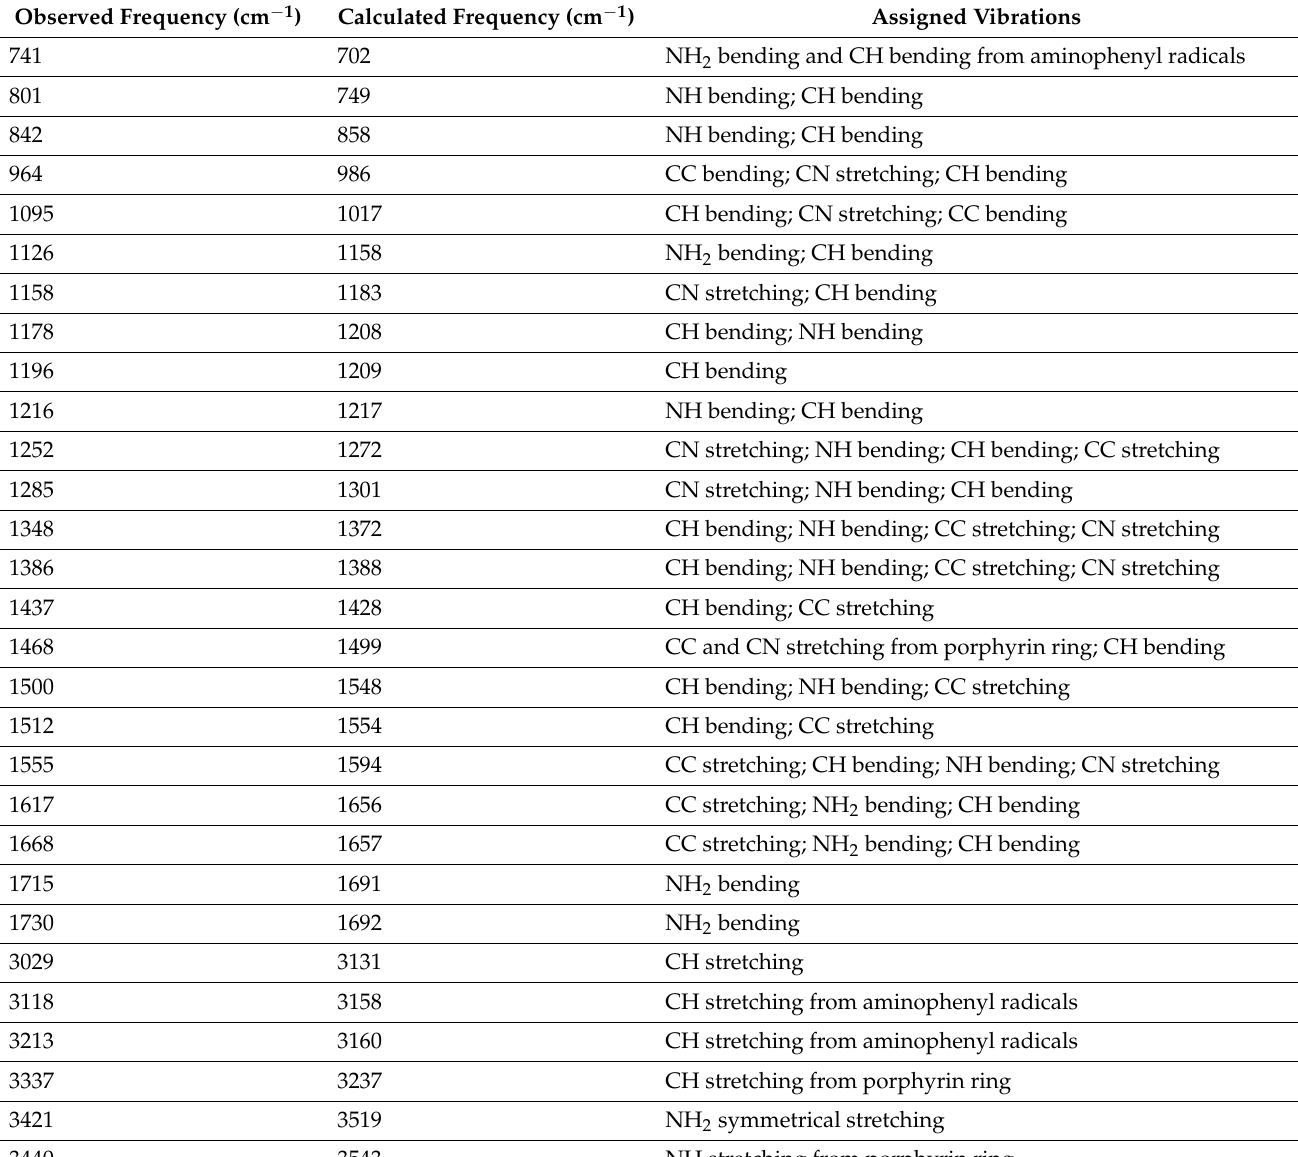
Table 3. Experimental and calculated frequencies for